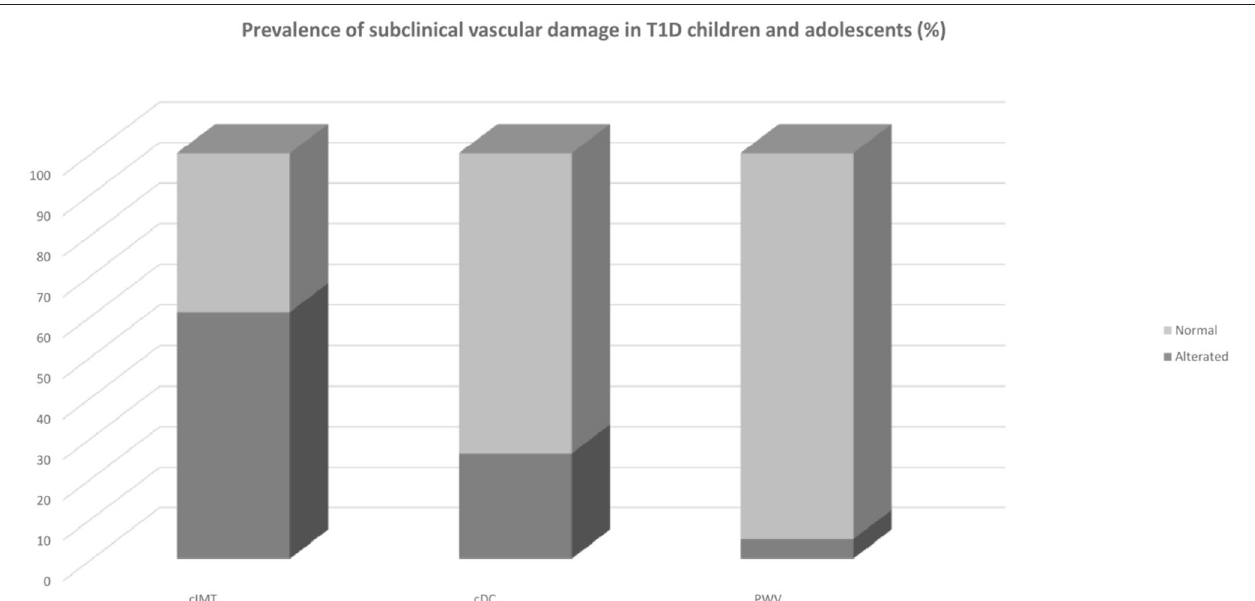
FIGURE 1 | Prevalence of subclinical vascular damage in T1D children and adolescents. cDC, carotid distensibility coefficient; cIMT, carotid Intima-Media Thickness; PWV, pulse wave velocity; T1D Type 1 Diabetes.